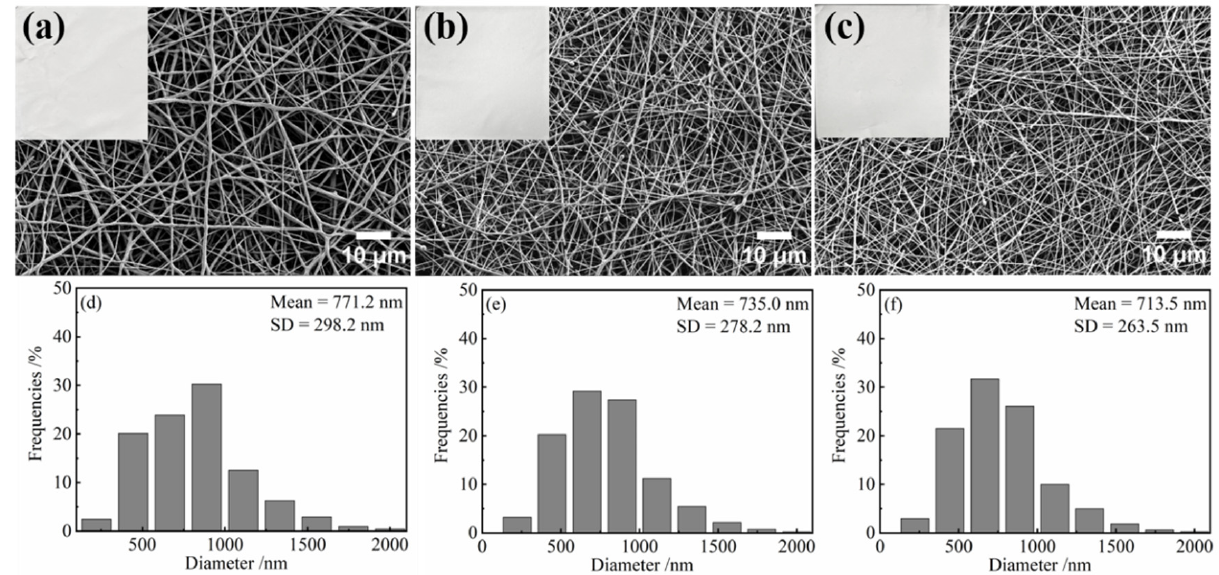
Figure 1. Photos, SEM images, and fiber diameters of electrospun nanofiber scaffolds spun from pure PCL solution ( a , d ) and from solutions with PCL/TA weight ratios of 9.5:0.5 ( b , e ) and 9:1 ( c , f ); the fiber diameter of electrospun PCL/TA (9.5:0.5, 9:1) nanofiber scaffolds are significantly different from the pure PCL nanofiber scaffolds, p < 0.05.